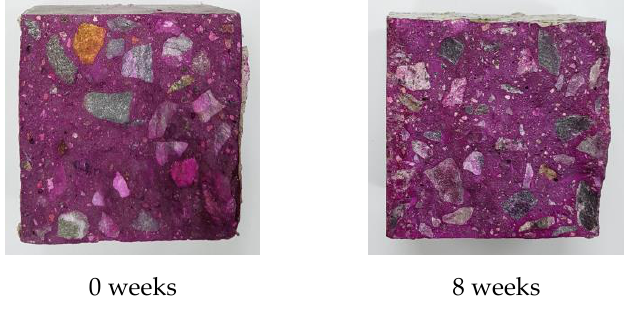
Figure 7. Carbonation test results for SF35.